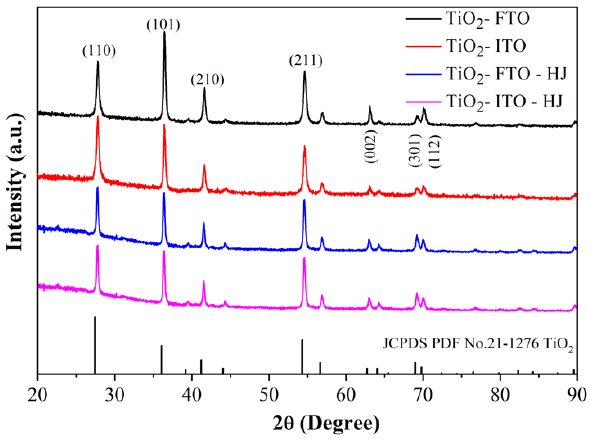
Figure 7. The XRD spectrum of TiO 2 nanoarrays.